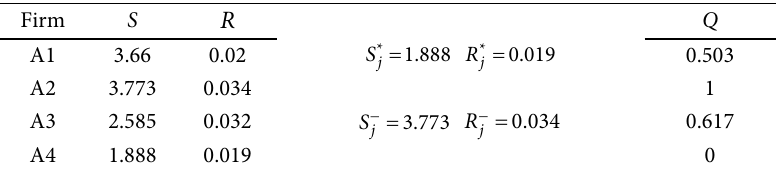
Table 5. The values of S and R for all the states